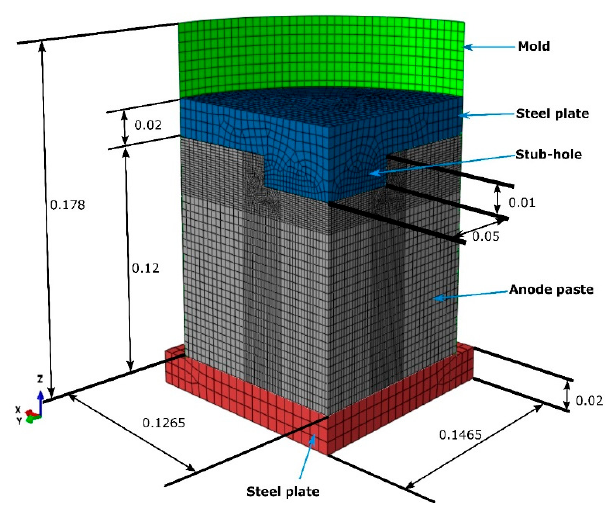
Figure 21. CAD model for the test with the stub hole (m). Materials 2019 , 12 , x FOR PEER REVIEW